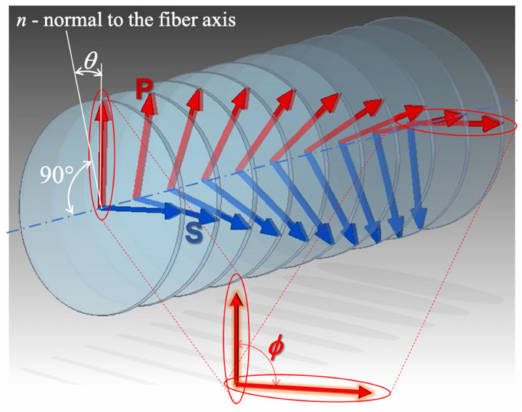
Figure 3. Twisting of the TFBG structure by the angle φ . Red arrows indicate P-type polarization, blue arrows correspond to S-type